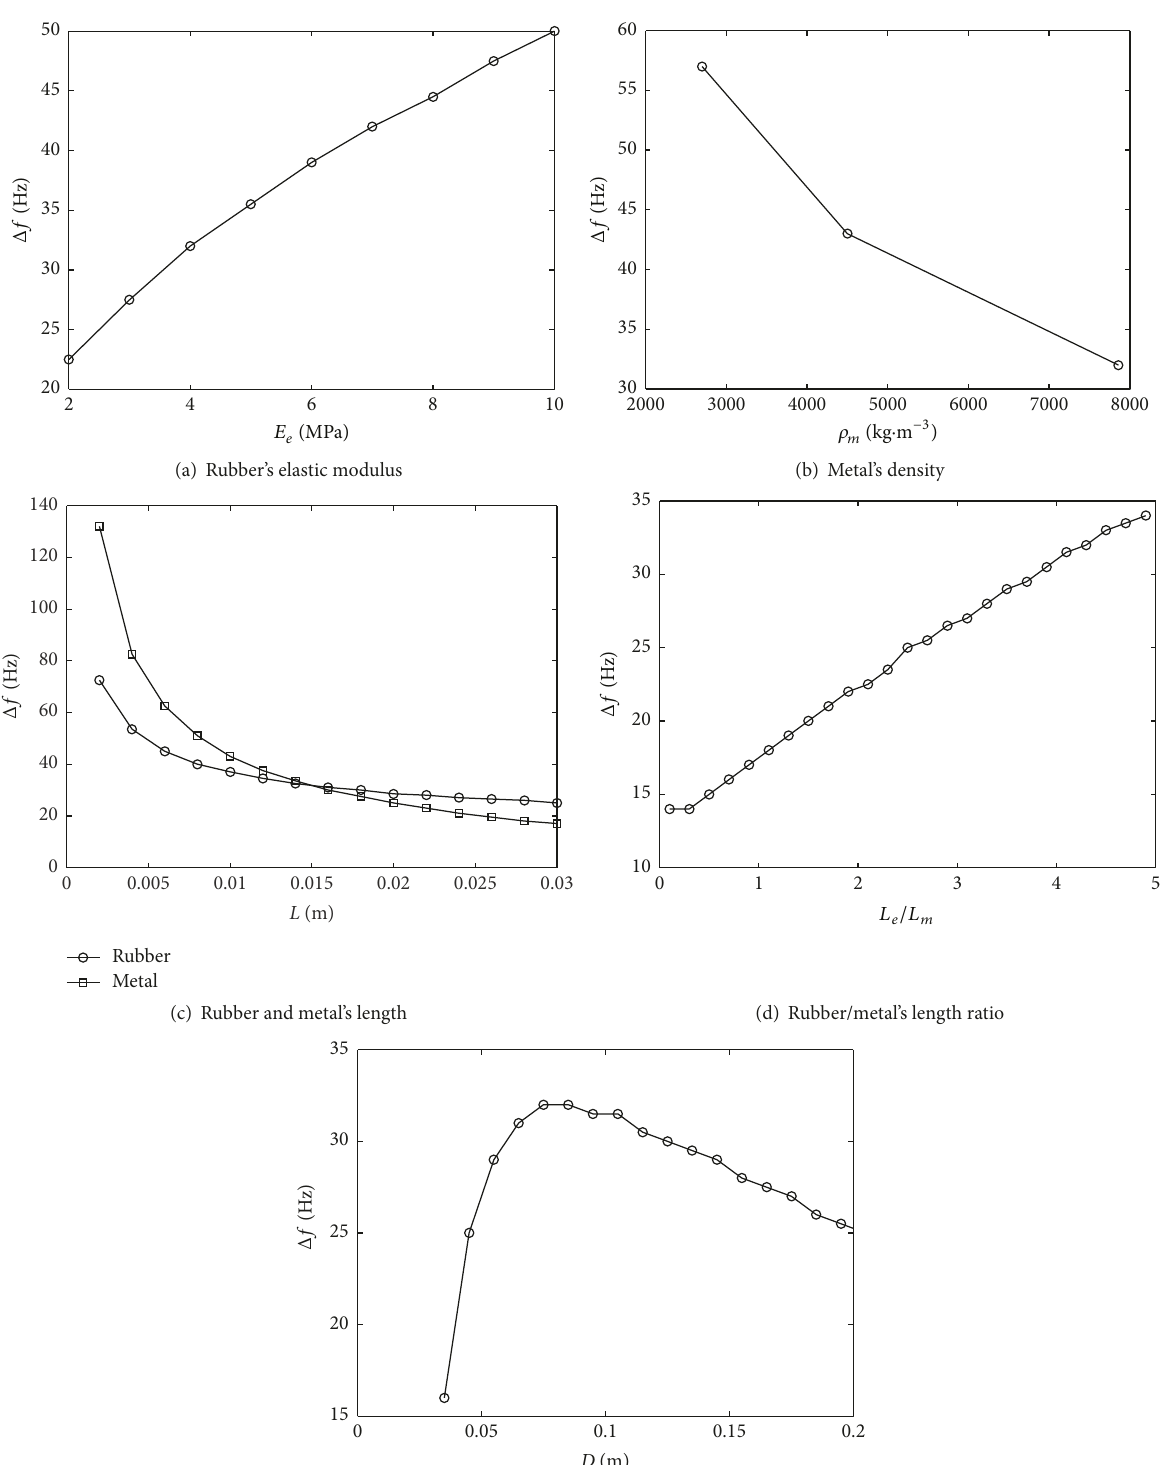
Figure 3: Curves of influence of the boundary conditions on the vibration